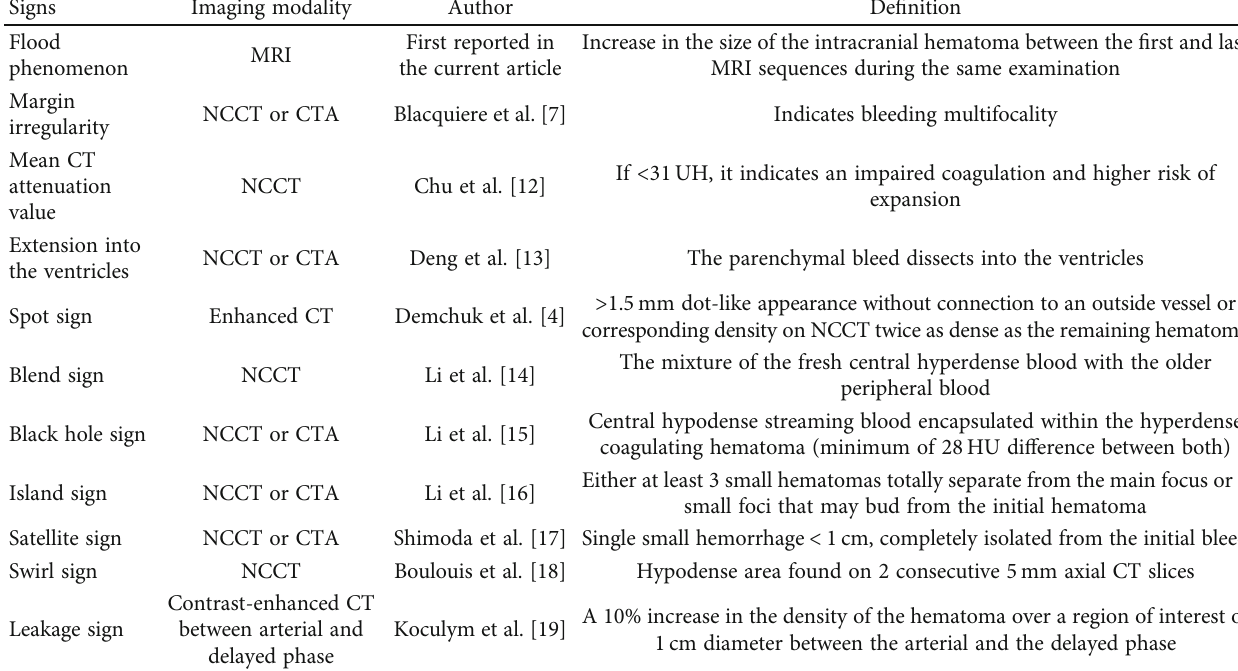
Table 1: Signs of hematoma heterogeneity or in predicting its